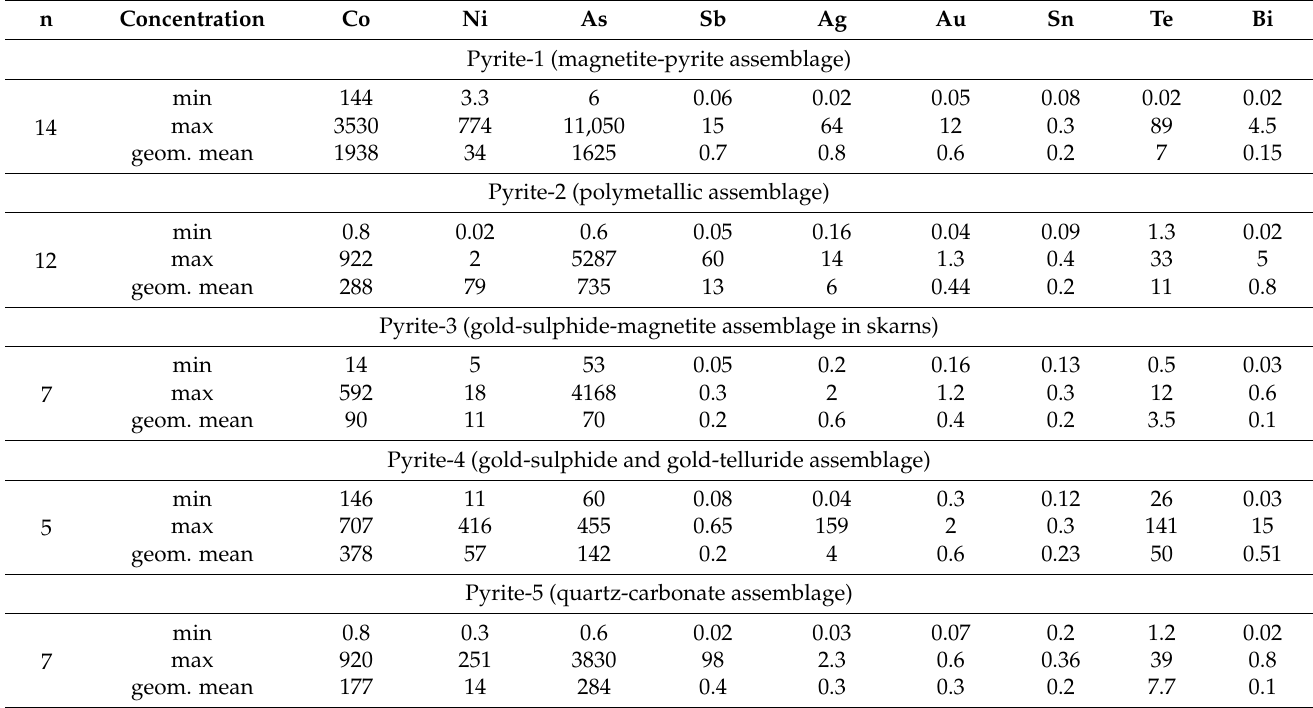
Table 14. The trace element contents (ppm) in pyrite of different assemblages of the Novogodnee-Monto deposit according to LA-ICPMS data.